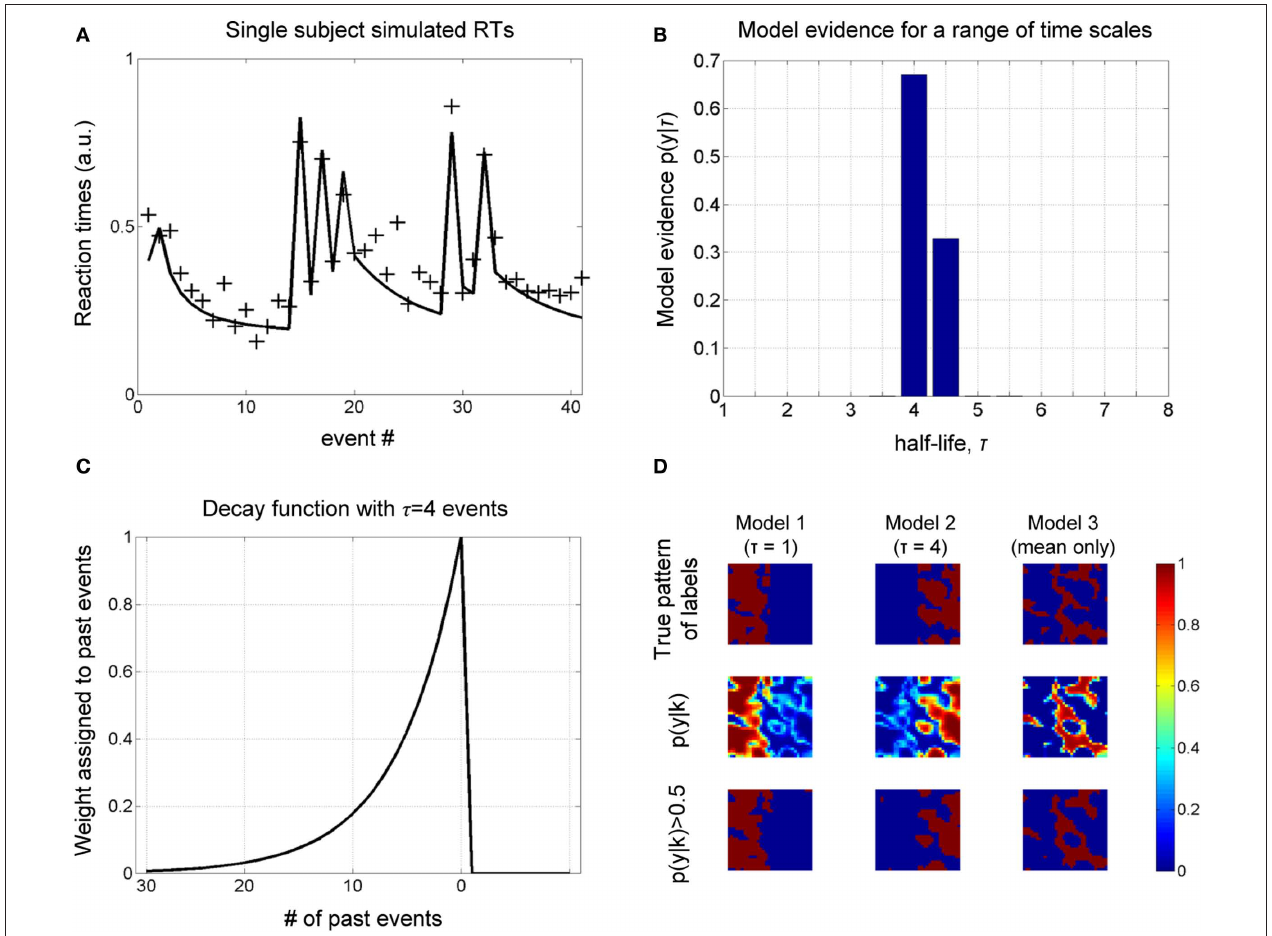
(D) Simulation of spatial data. A square region is partitioned into three areas (labels), corresponding to three different generative models. Data are generated at each pixel depending on the sampled input, u (see Figure 3A ), and label assigned to it. The objective is to recover the true pattern of labels, given only these data, i.e., without direct knowledge of the true labels. The true pattern of labels is along the top row, while the estimated probability of belonging to a label is shown below, which is thresholded to give a binary map along the